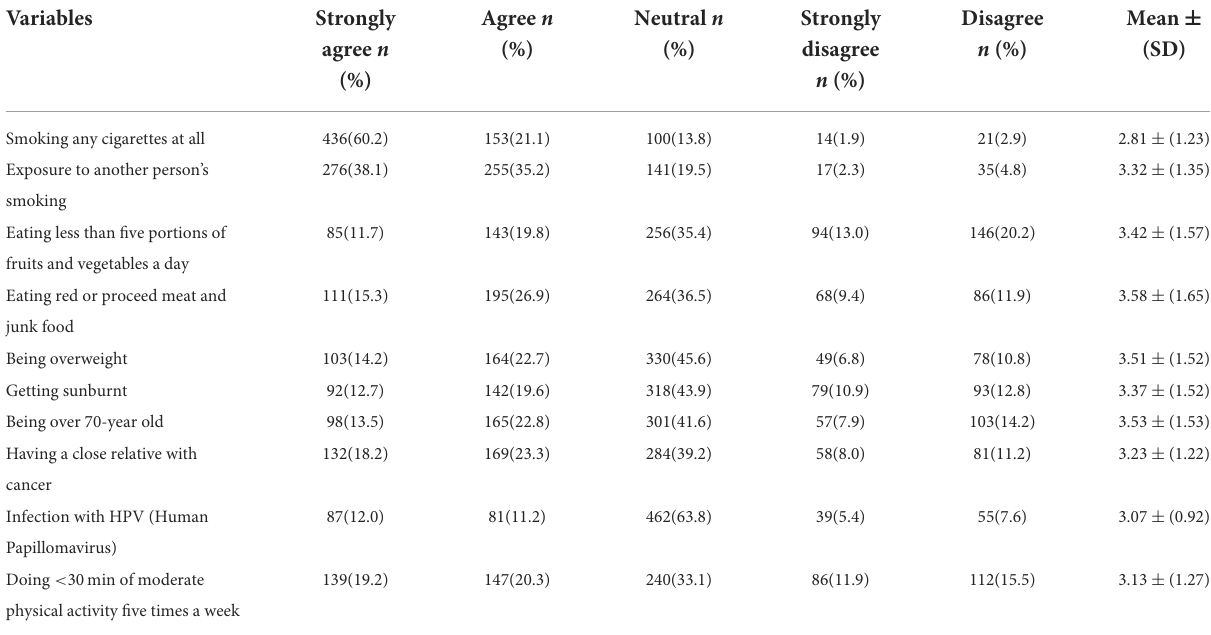
TABLE 4 Perception regarding chances of developing